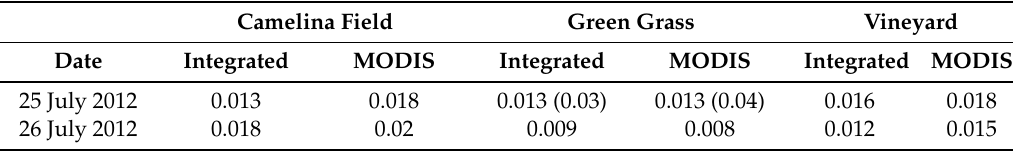
Table 5. RMSE values for the validation of airborne albedos of the three studied sites. The Integrated Albedo was calculated by integration of the at-surface solar irradiance. The MODIS Albedo was calculated using the MODIS apparent albedo equation adapted to the AHS channels. For the green grass, the data for VZA = ´ 44.8 ˝ of the 9:38 UTC flight was discarded. The values in brackets are calculated taking the data into